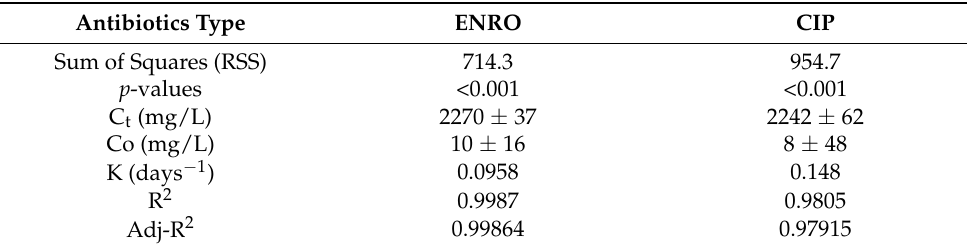
Figure 5. Gompertz model patterns. ( a ) CIP residual plot, ( b ) CIP line of best fit, ( c ) ENRO residual plot, ( d ) ENRO line of best fit. Table 1. ANOVA Gompertz model summary.